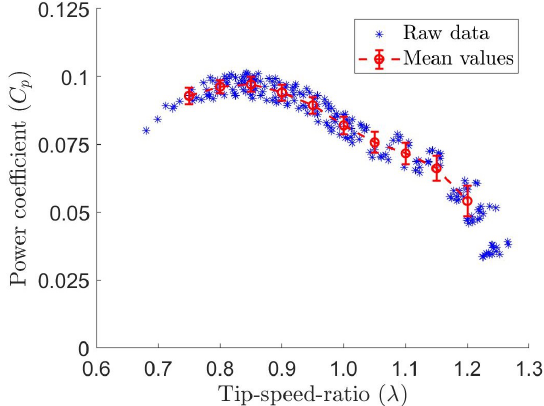
Figure 10. Raw measurements of turbine T1 power coefficient as a function of its tip-speed-ratio. The raw data was averaged with each error bar calculated as the standard